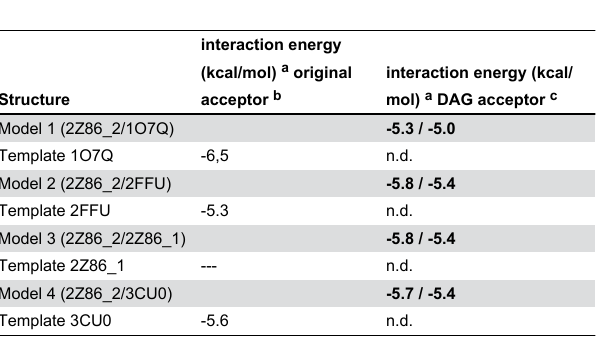
Table 3. Estimation of interaction energies of the acceptor substrates to modeled and template